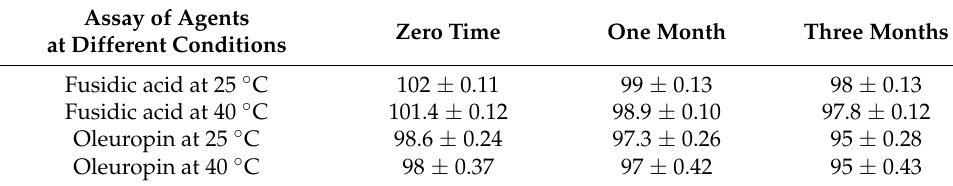
Table 4. Percent fusidic acid and oleuropein content in formula F2 at zero time, one month, and